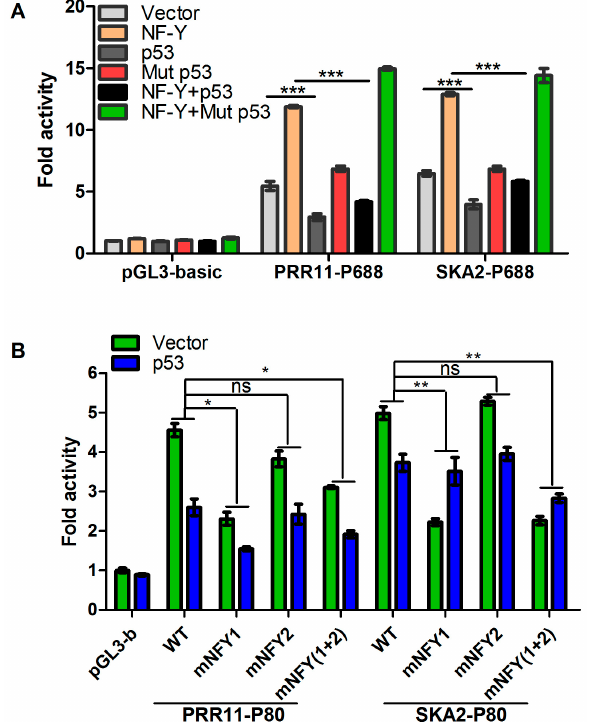
Figure 3. p53 represses the transcriptional activation of the PRR11-SKA2 bidirectional promoter through NF-Y binding sites. ( A ) p53 overexpression attenuates NF-Y-mediated transactivation of the PRR11-SKA2 bidirectional promoter. H1299 cells were transiently co-transfected with the indicated luciferase reporter constructs along with NF-YB , p53 , and/or mutant p53 expression plasmids. Forty-eight hours after transfection, cells were lysed, and luciferase activities were examined as described in Figure 1; ( B ) Disruption of the NF-Y binding sites decreases the repression of the PRR11-SKA2 bidirectional promoter by p53. Site-directed mutations were introduced into the parental PRR11- or SKA2-P80 ( − 480/ − 401) luciferase reporter constructs to disrupt one (mNFY1 and mNFY2) or both (mNFY(1 + 2)) NF-Y binding sites in the PRR11-SKA2 bidirectional core promoter region. H1299 cells were transiently co-transfected with the indicated luciferase reporter constructs containing wild type or mutated NF-Y binding sites, together with empty or NF-YB expression vectors. Forty-eight hours after transfection, luciferase activities were determined as described for Figure 1. * p < 0.01, ** p < 0.01, *** p < 0.001. ns, non-significant.